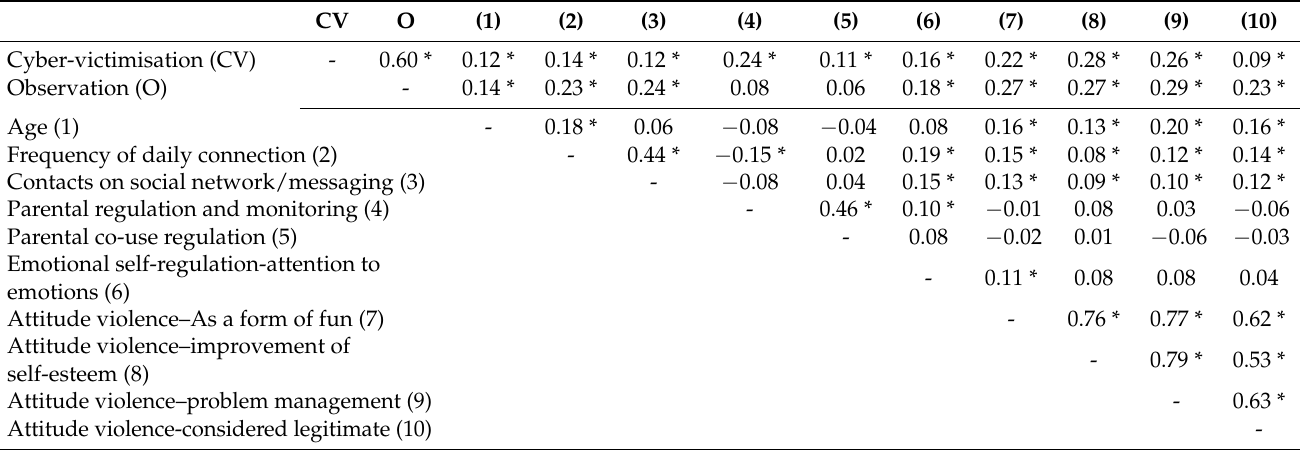
Table 4. Correlation of variables X-Y.